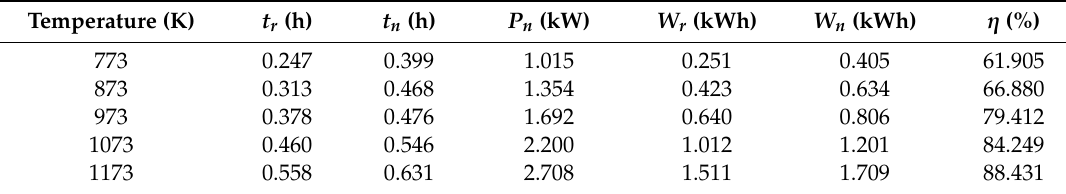
Table 3. The e ff ect of combustion temperature on power consumption. Table 3. The effect of combustion temperature on power consumption.